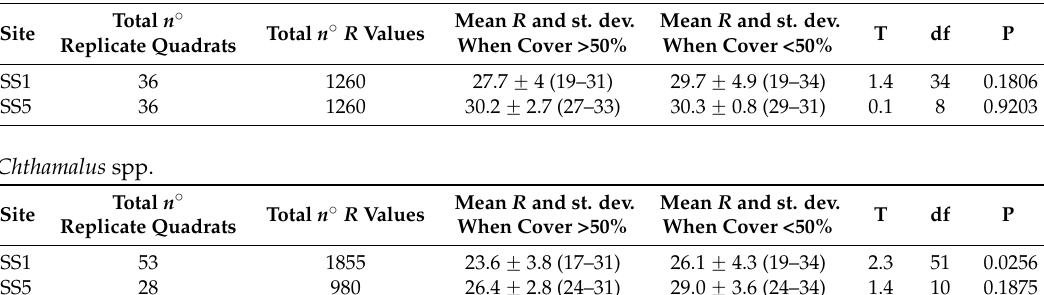
Table 2. T -test results for SS1 and SS5 for both biota.